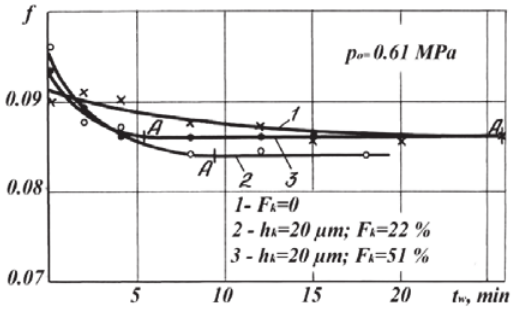
Fig. 12. Determining the time of the micro running-in completion t w according to the stabilized friction factor